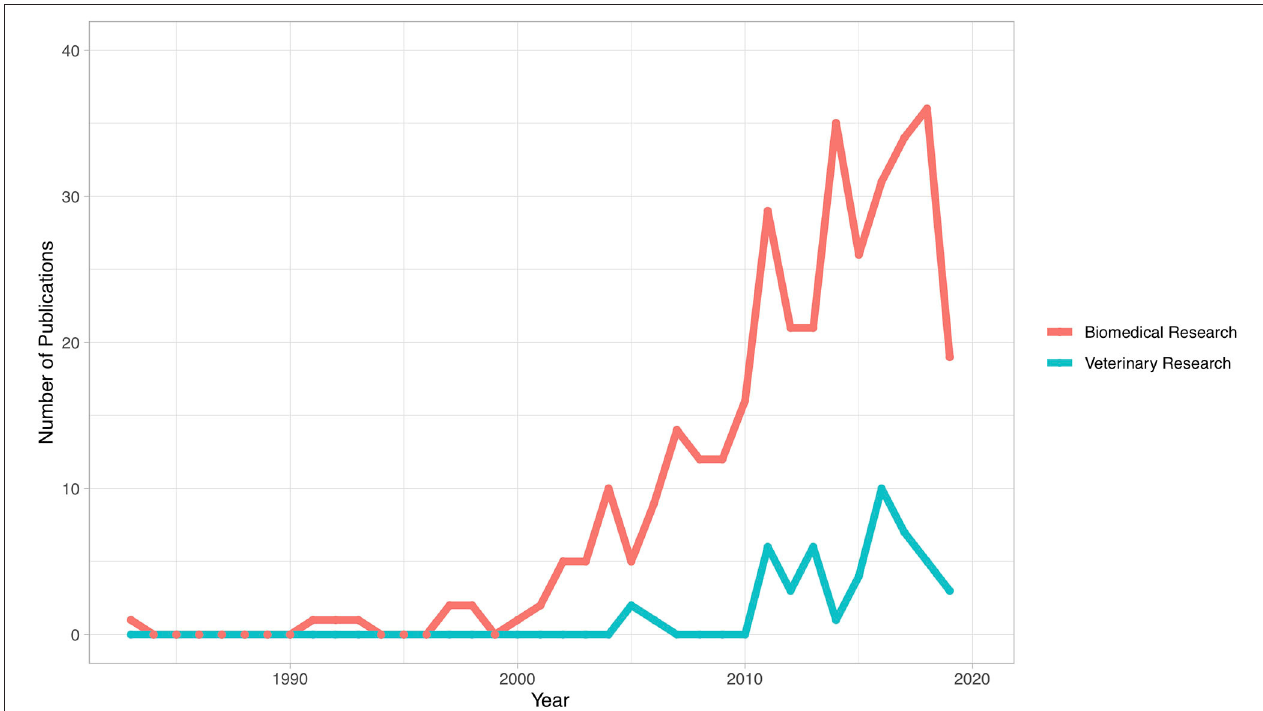
FIGURE 3 | Year of publication for publications included in a scoping review of the evidence for the medicinal use of natural honey in animals ( n = 397). Shaded region represents an incomplete picture of the total number of publications in 2019, since the search was performed in September 2019 and thus did not capture all studies published in that year.